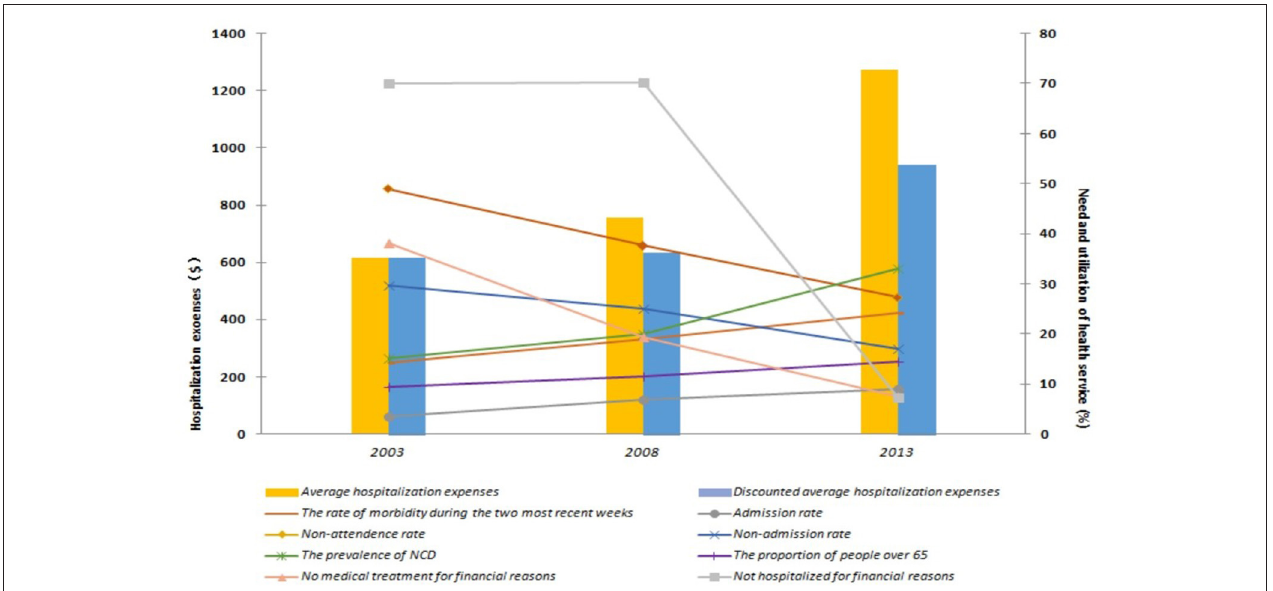
FIGURE 1 | Comparison of health-care needs and service utilization in 2003, 2008, and 2013. $: USD, United States Dollar. According to the exchange rate of 6.1932 yuan to US$ 1.00.